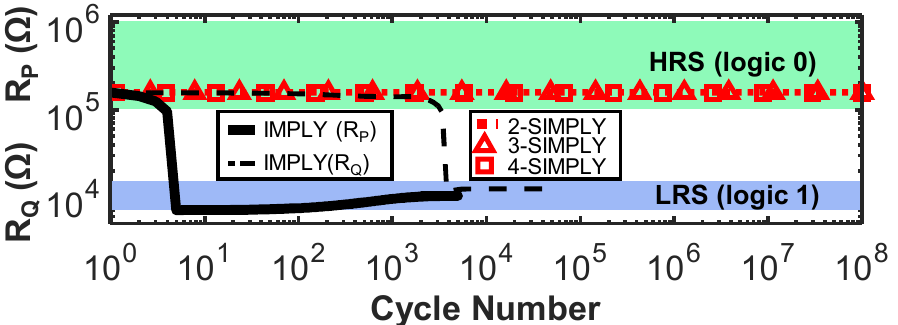
Figure 5. Degradation profiles of R P (dashed black line) and R Q (solid black line) over time during the repeated execution of IMPLY (technology 3 [29]). R P degrades when repeating IMPLY for input combination P = Q = 0; R Q degrades when repeating IMPLY for input combination P = 1 and Q = 0. The degradation depends on the initial values of R Q and R P , (worst-cases for R Q and R P shown here, considering variability and RTN). Bit corruption occurs potentially after only 7 cycles (solid black line). No noticeable degradation occurs using SIMPLY (only worst-case reported) up to at least 10 8 cycles, also when performing multi-input operations (i.e., n -SIMPLY when n = 2, 3, 4—dotted red line, red triangles, and red squares, respectively). Table 1. Energy consumption comparison of the 2-IMPLY operation in IMPLY and SIM- PLY architectures with technology 3. The use of SIMPLY enables the use of a lower V SET voltage (V SET, IMPLY = 3.2 V, V SET, SIMPLY = 3 V). In all cases, 1ns voltage pulses are considered (t 2-IMPLY = 2 · t PULSE , t 2-SIMPLY = 4 · t PULSE ), V READ = 0.2 V, the effects of variability, RTN, and compara- tor energy overhead are included. Energy consumption data are from [30].